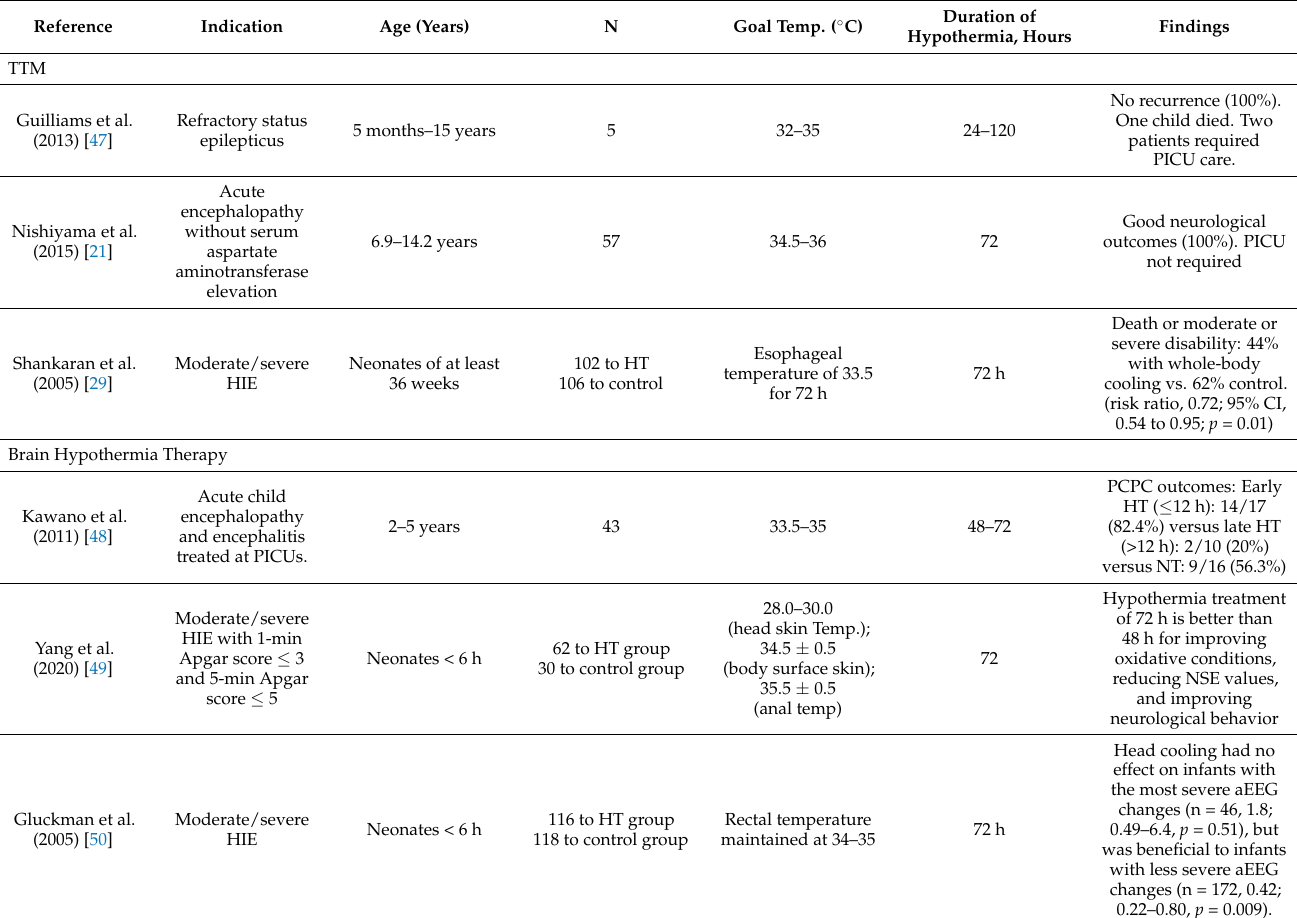
Table 2. Summary of clinical studies and case reports for targeted temperature management in acute encephalopathy